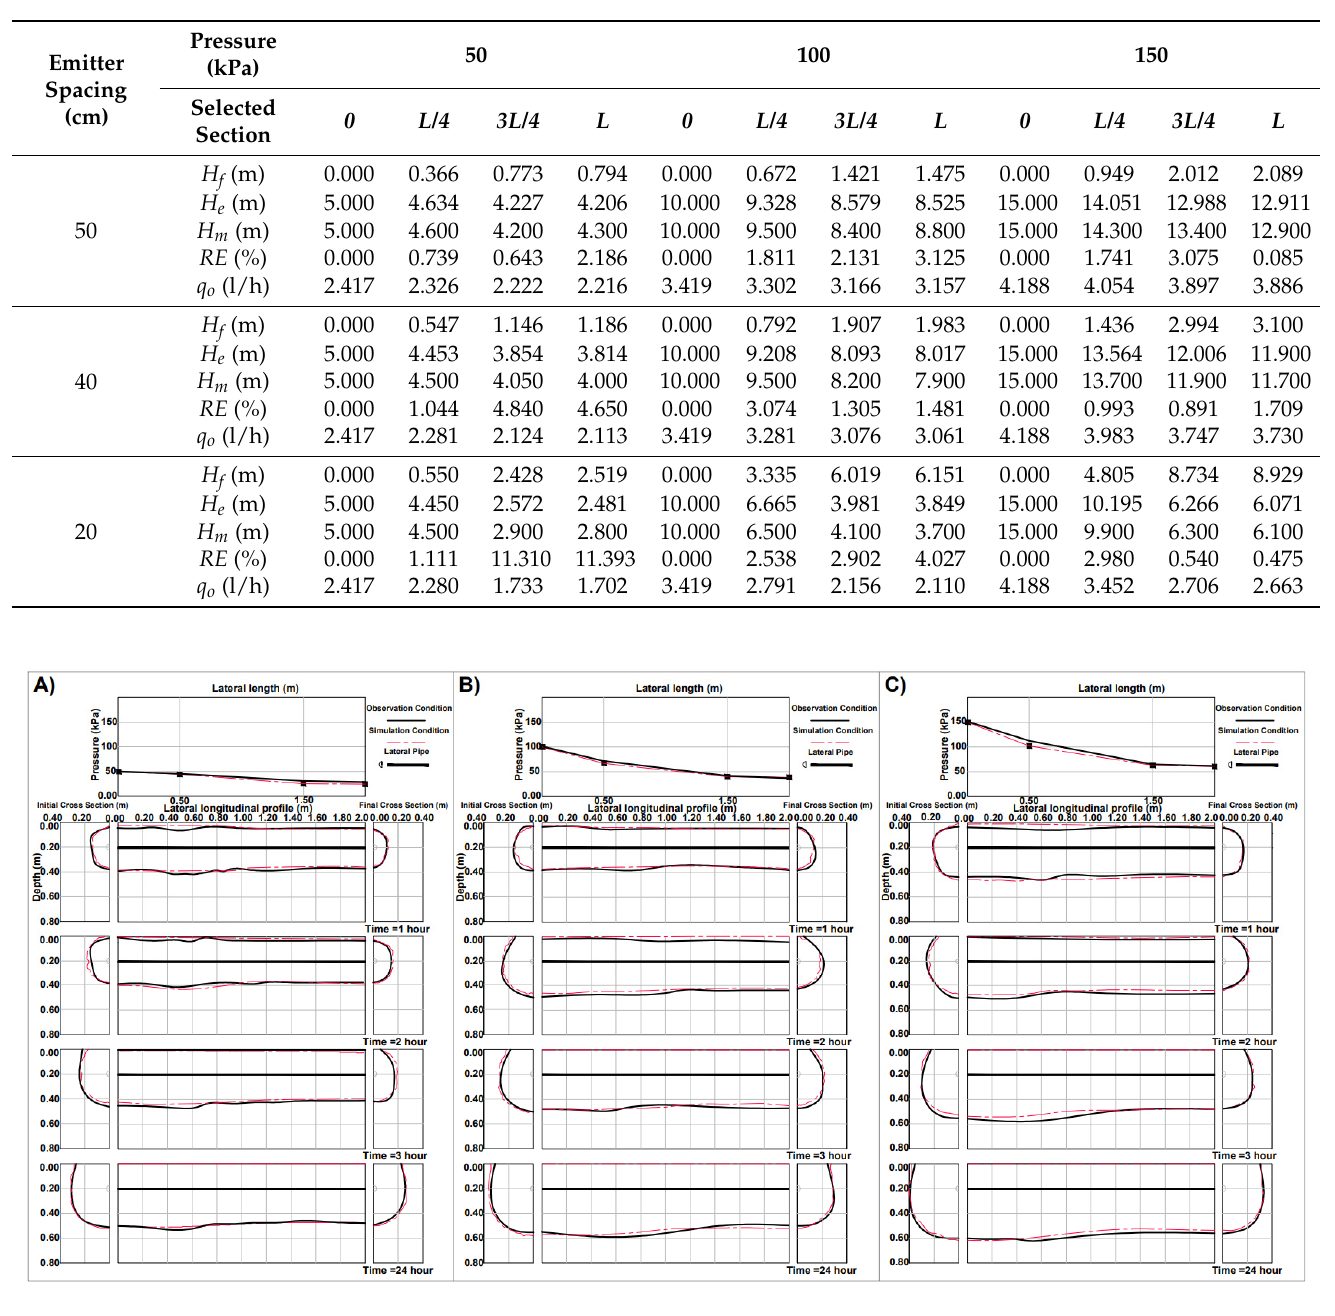
Figure 6. Comparison between observed and simulated wetting fronts for drip lateral with 40 cm emitter spacing at operating pressures of ( A ) 50 kPa, ( B ) 100 kPa, and ( C ) 150 kPa.